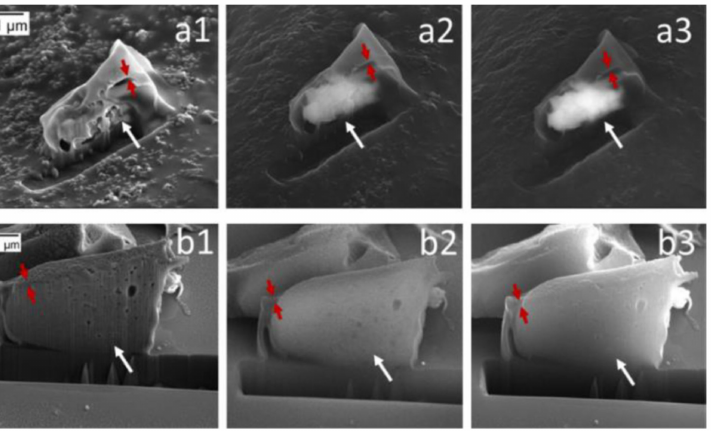
Figure 8. FIB-SEM cross-sectional image of capsules filled with ( a ) FeCl 2 crystals and ( b ) Fe 3 O 4 nanopowder obtained with ( 1 ) SE, ( 2 ) BSE detector, and ( 3 ) overlaid image. White arrows indicate the cargo crystals inside the capsules, while red arrows indicate the shell polymer layer